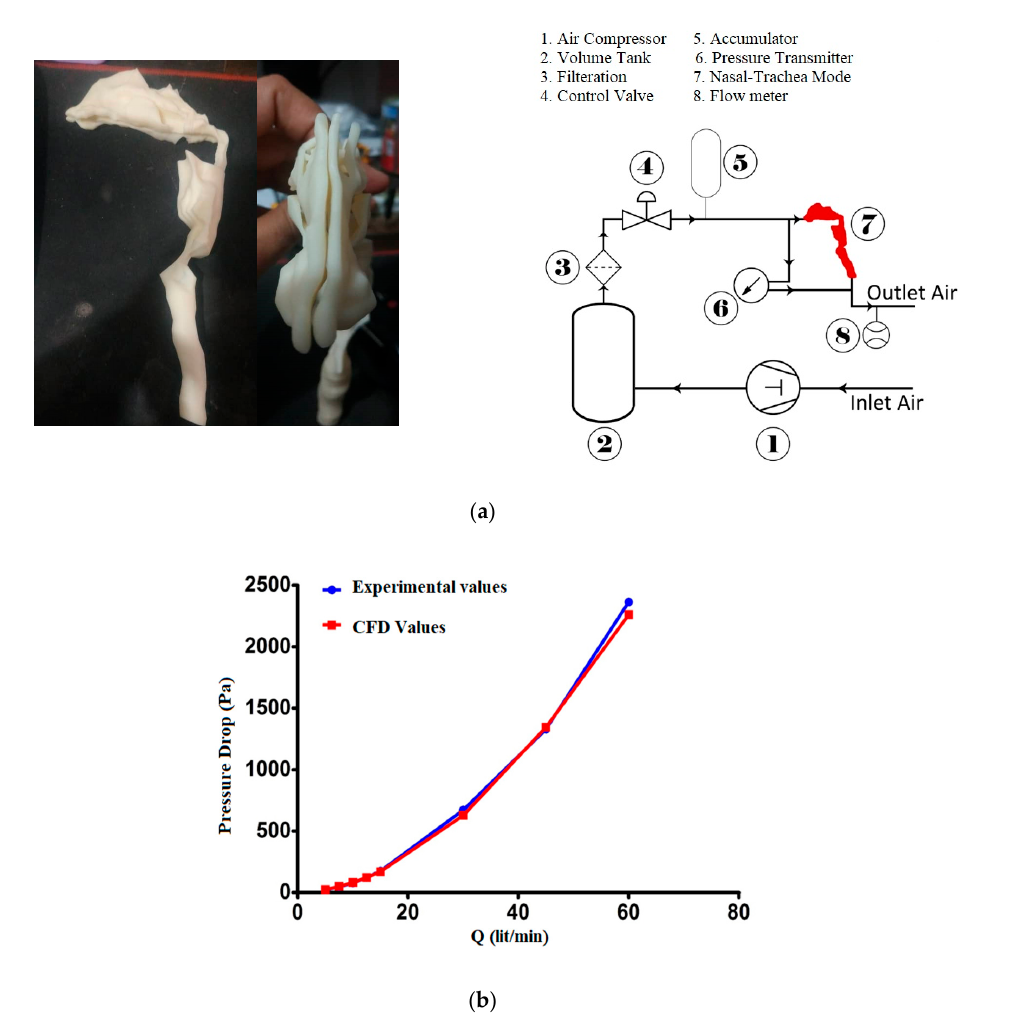
Figure 3. Experimental setup and validation; ( a ) different views of the constructed three-dimensional model and configuration of the experimental setup; ( b ) comparison between the pressure drops derived from numerical models and experiments as a function of inhalation flow rate ( Q ).